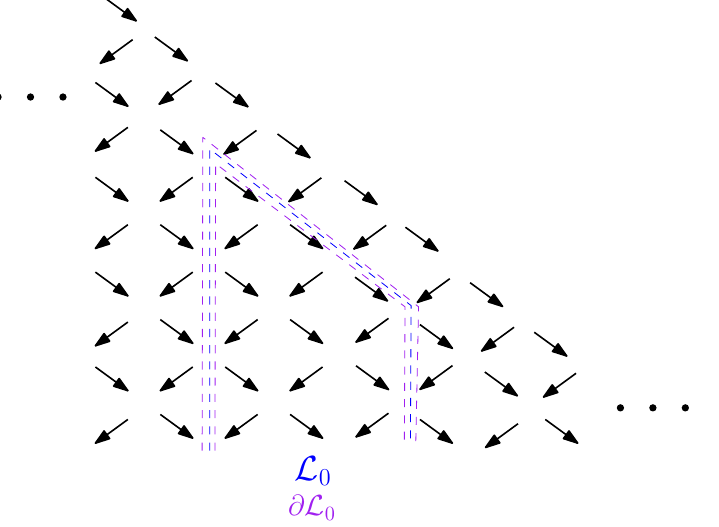
Figure 6. Region L 0 is highlighted with blue dashed lines. Its boundary ∂ L 0 is a set of points highlighted with purple dashed